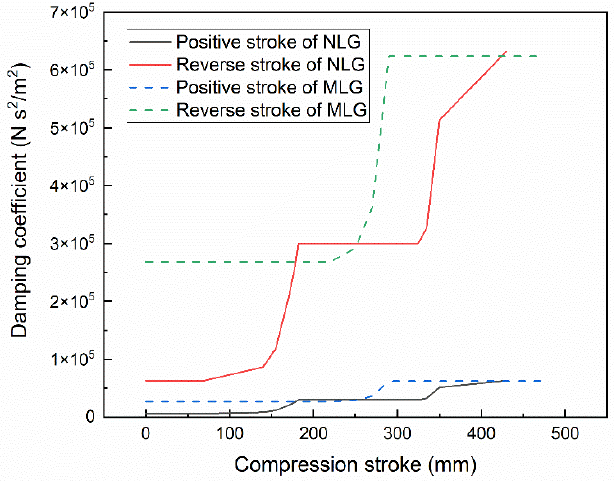
Figure 3. Oil damping coefficient of positive and reverse stroke of landing gear shock absorber.